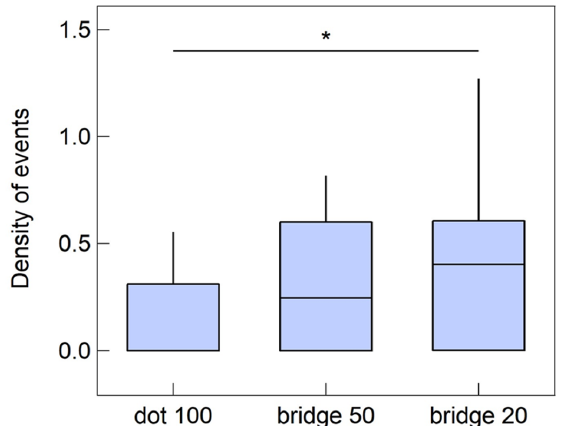
Figure 8. Density of calcium events as defined in the main text, for cells located on different areas of the patterned substrates, consisting of dots of 100 μ m diameter connected by bridges with a width of either 50 μ m or 20 μ m. The symbol * stands for outliers.